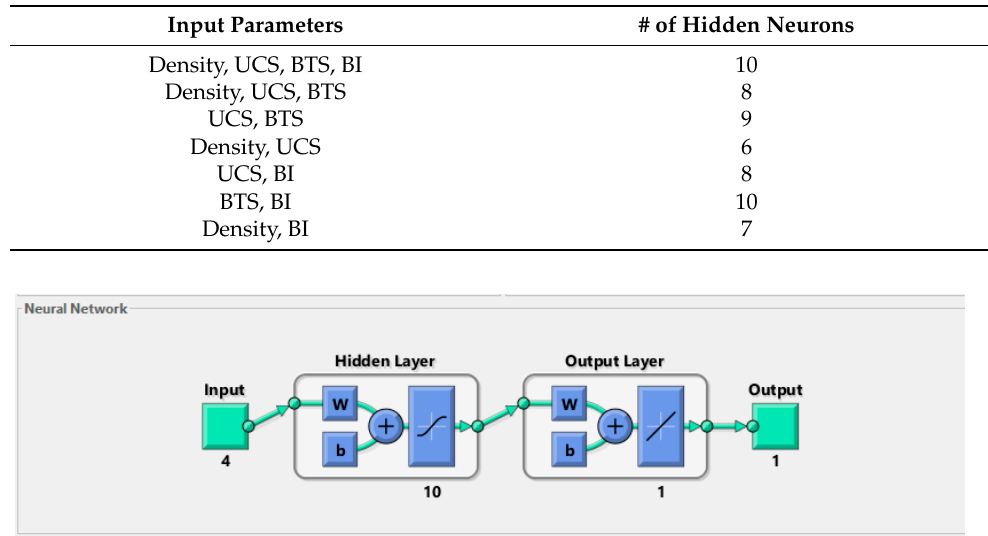
Table 11. Number of hidden neurons for 80 sample inputs.